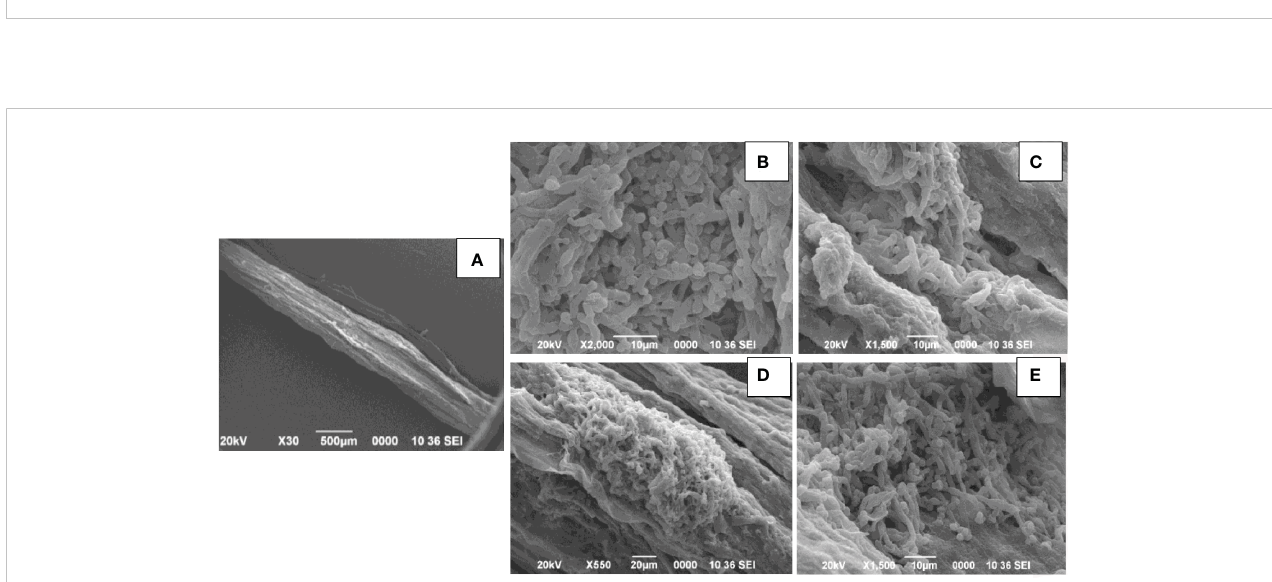
FIGURE 12 Scanning electron microscopy of primary roots of tomato seedling. (A) . Control: Ralstonia solanacearum inoculated- damaged roots. (B – E) . Trichoderma harzianum MC2 + Trichoderma harzianum NBG inoculated colonization of Trichoderma spp. in the root